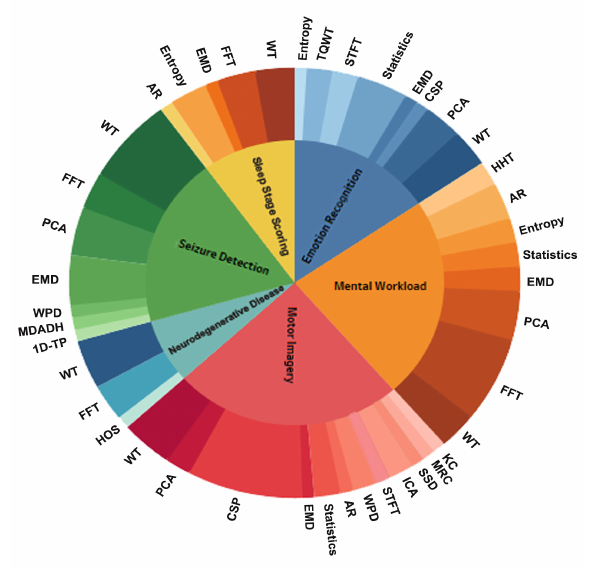
Figure 7. Feature extraction methods used in all studies considered in this review. The inner circle represents the type of task, and the outer circle represents the utilization rate of the method for each task. Abbreviations: AR, autoregressive; CSP, common spatial pattern; EMD, empirical mode de- composition; FFT, fast Fourier transform; HHT, Hilbert Huang transform; HOS, higher-order spectra; ICA, independent component analysis; Kc, Kolmogorov complex; MDADH, maximum difference of amplitude distribution histogram; MRC, multiple Riemannian covariance; PCA, principal component analysis; STFT, short-time Fourier transform; SSD, sparse spectrotemporal decomposition; TQWT, tunable Q wavelet transform; WPD, wavelet packet decomposition; WT, wavelet transform; 1D-TP, one-dimensional ternary